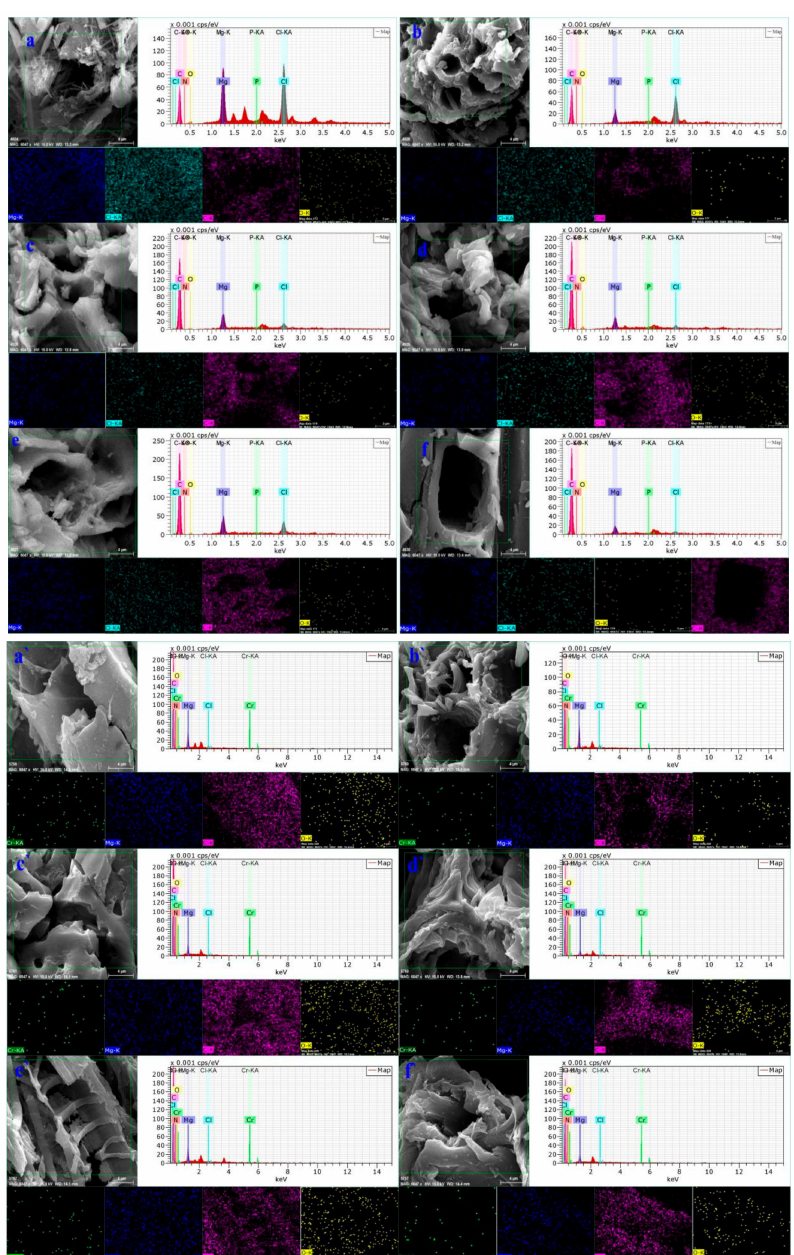
Figure 3. Scanning electron microscopic images of the six biochars. a , a ’; b , b ’; c , c ’; d , d ’; e , e ’; and f , f ’ represent before and after Cr(VI) adsorption on BSB, CSB, MSB, CFSB, TSB, and FSB,